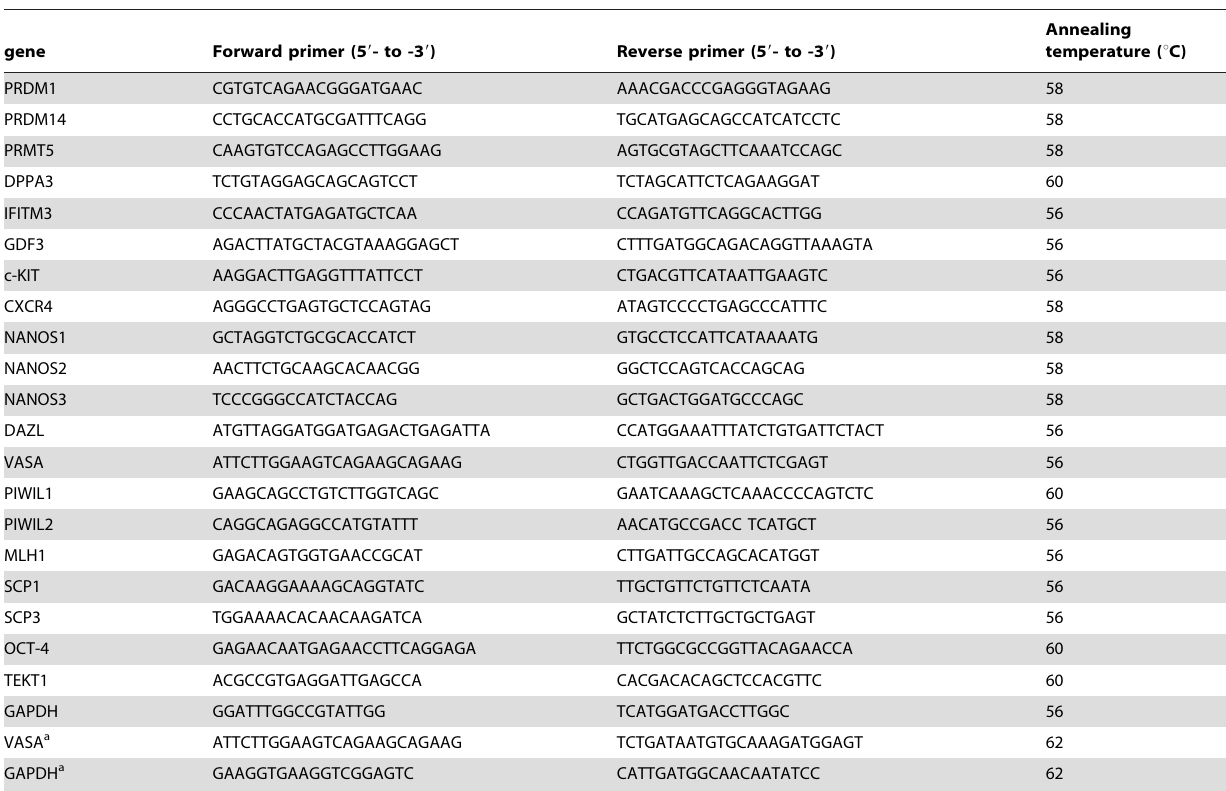
Table 1 . List of RT-PCR and quantitative RT-PCR primers